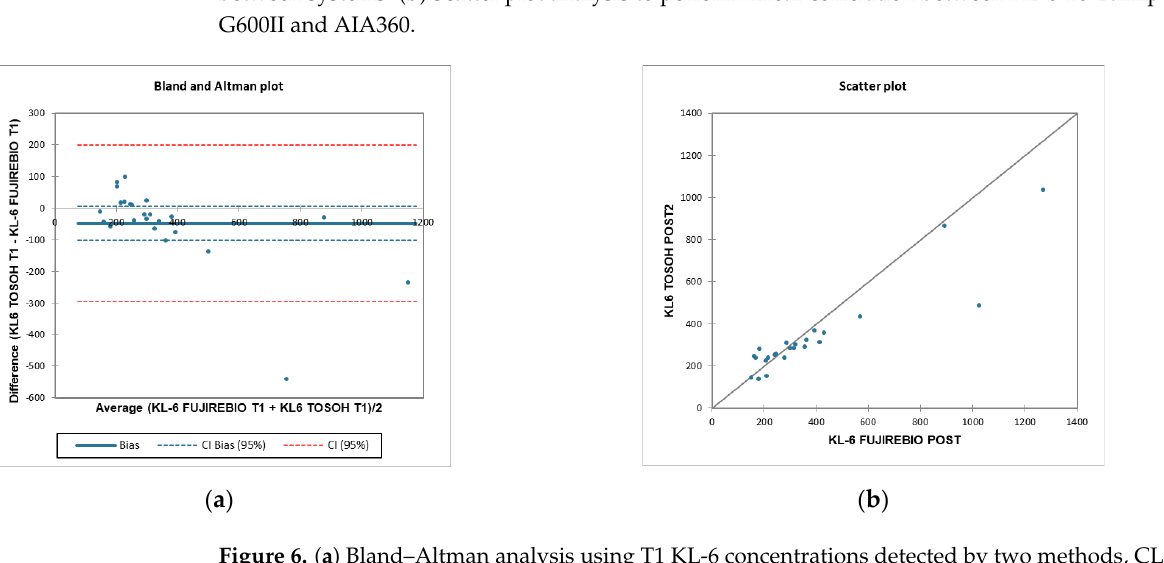
Figure 6. ( a ) Bland–Altman analysis using T1 KL-6 concentrations detected by two methods, CLEIA and FEIA by Lumipulse G600II and AIA360 system, respectively, for assessing agreement and Bias between systems. ( b ) Scatter plot analysis to perform linear correlation between KL-6 T1 Lumipulse G600II and AIA360.